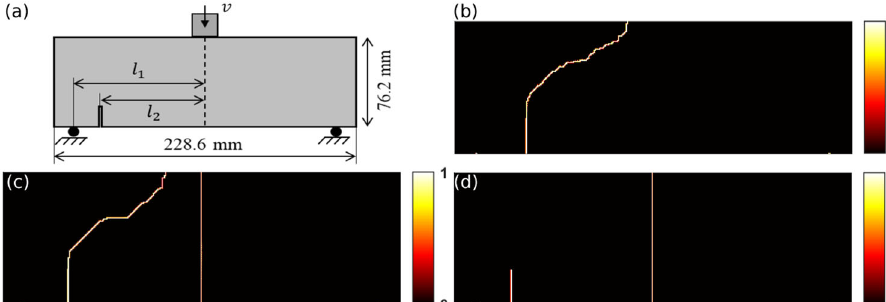
Fig. 3 Simulation of the John – Shah experiment. a Schematic of the John – Shah experiment 46 involving the impact loading of a pre-notched concrete beam resting on simple supports. The length of the initial notch is 19.4 mm. The numerically obtained crack patterns for different notch locations b γ = 0.72, c γ = 0.76, and d γ = 0.79. Similar to the experiment, the crack nucleates from the tip of the notch for γ = 0.72 < γ c , from the mid-span of the beam for γ = 0.79 > γ c , and from both the notch tip and mid-span for γ =